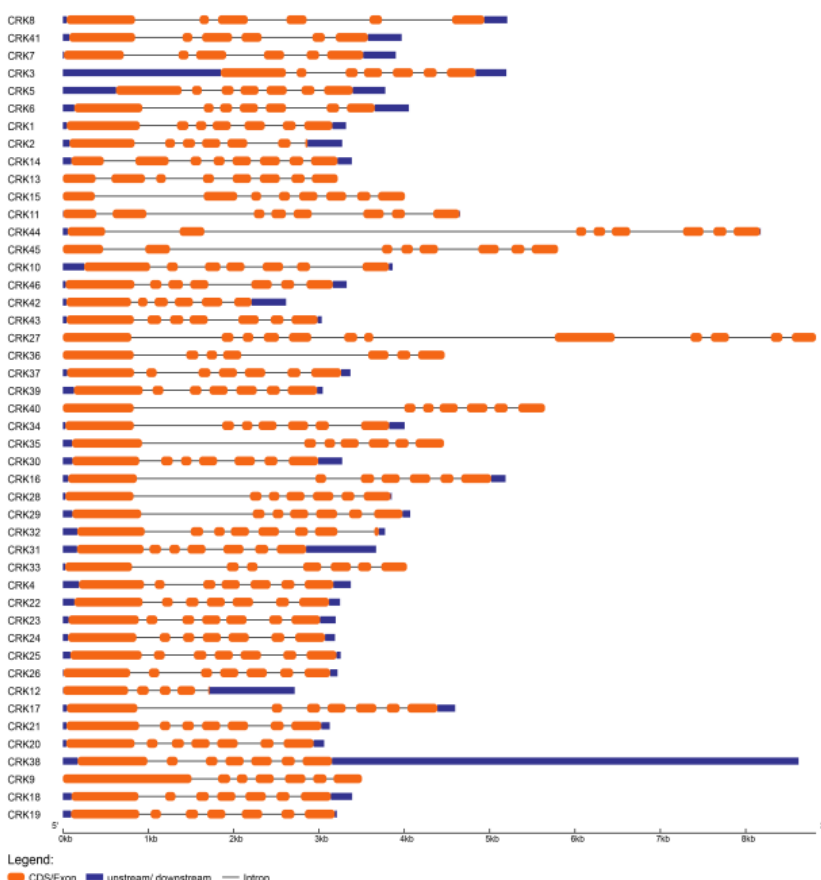
Figure 2. Gene structure analysis of Phaseolus cysteine-rich receptor-like kinases (CRKs). The intron–exon structures of PvCRK genes were analyzed using the Gene Structure Display Server (GSDS) database. Exons/Coding sequence (CDS) are represented by orange bars, introns by grey lines, and upstream (5′)/downstream (3′) untranslated regions (UTRs) are blue bars.